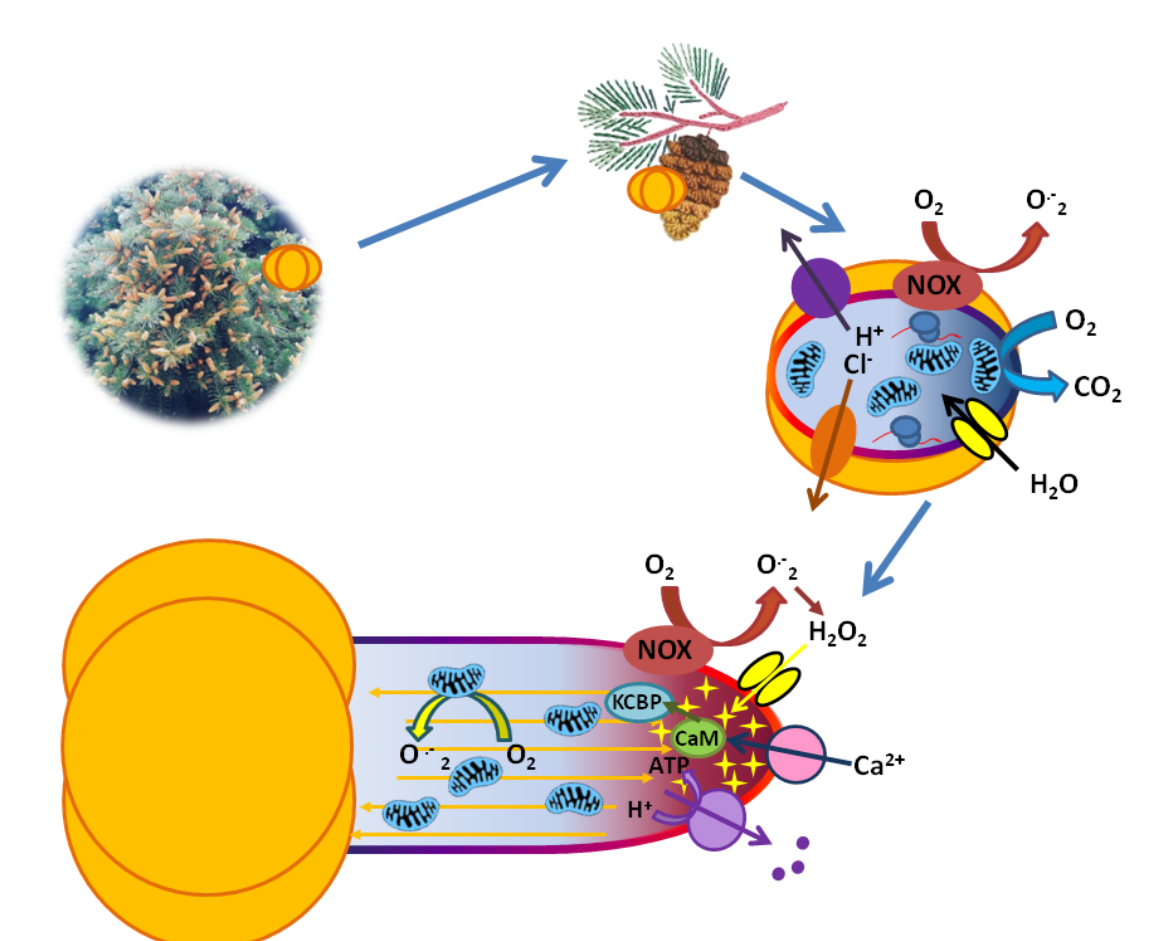
Figure 5. Structural and regulatory network in germinating conifer pollen and growing pollen tube. Mature pollen travels from male cones to female cones by wind, highly dehydrated and dormant. After its landing on a pollination drop, rehydration and then physiological activation occur. Anions are released from the grain (orange—putative anion channels involved), ROS are produced by NADPH-oxidase (NOX, brown), respiration is activated (blue), protein synthesis occurs in ribosomes, pH shifts from acidic to slightly alkaline values (cytoplasm gradient staining from left to right = from early to later activation stage) due to H + -ATPase activity (purple), and membrane hyperpolarization occurs (membrane gradient staining, from left to right).